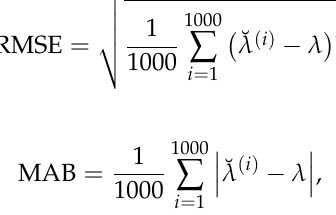
(cid:12) (cid:12) ˘ λ ( i ) − λ (cid:12) (cid:12) MAB = (cid:12) , (cid:12)